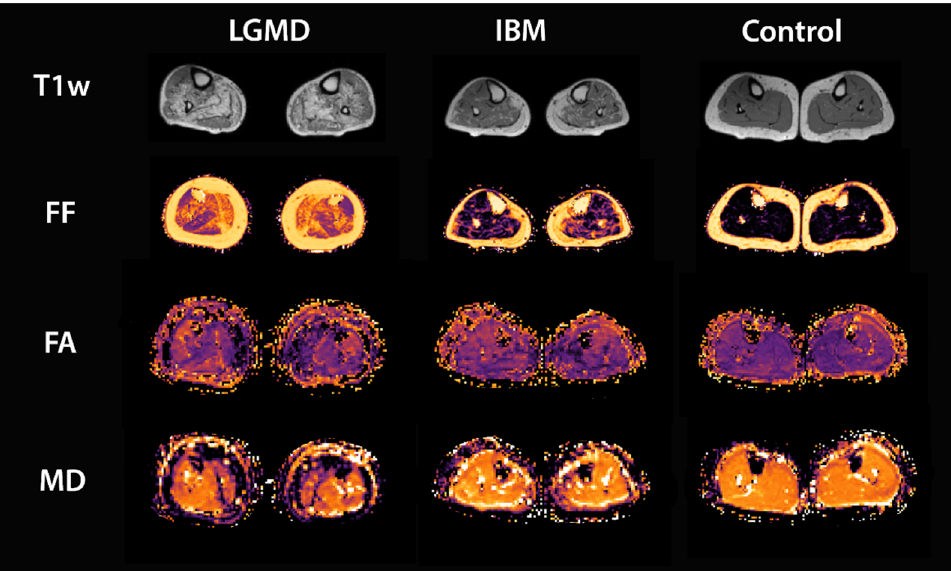
Figure 2. Example images of the applied MRI sequences: T1w, mDixon fat fraction (FF), FA and MD for lower legs of an LGMD, an IBM patient, and a healthy control.